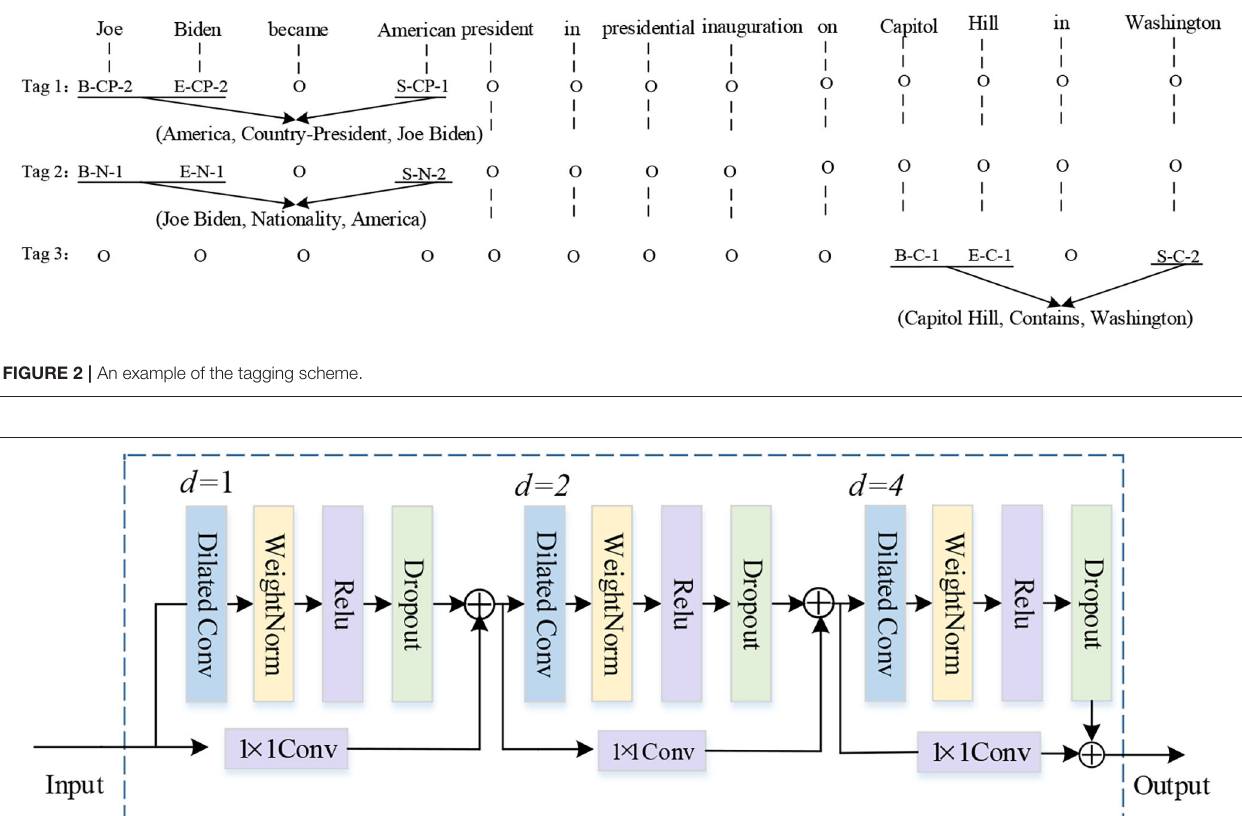
information from being generated but also tackle overlapping relations